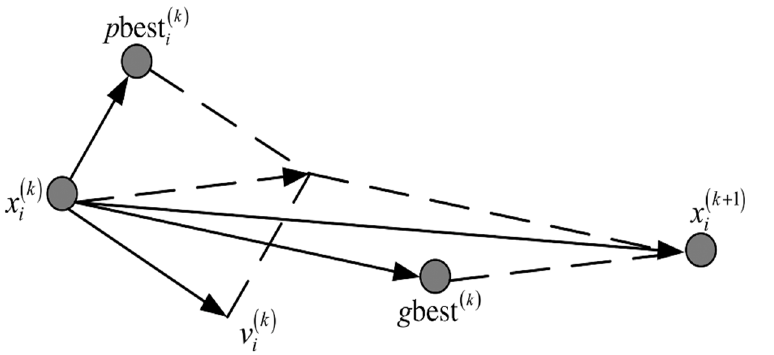
Fig 2. Illustration of the PSO